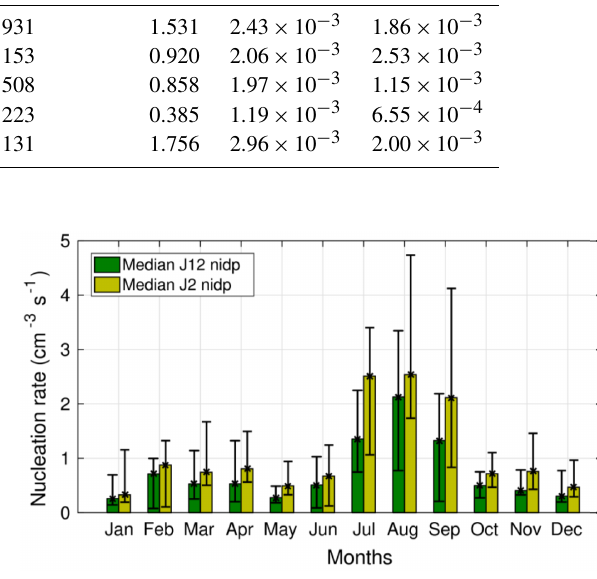
Figure 7. Monthly median nucleation rates in 2015 for 2 and 12nm sizes. Error bars in black represent 25th percentile (top) and 75th percentile